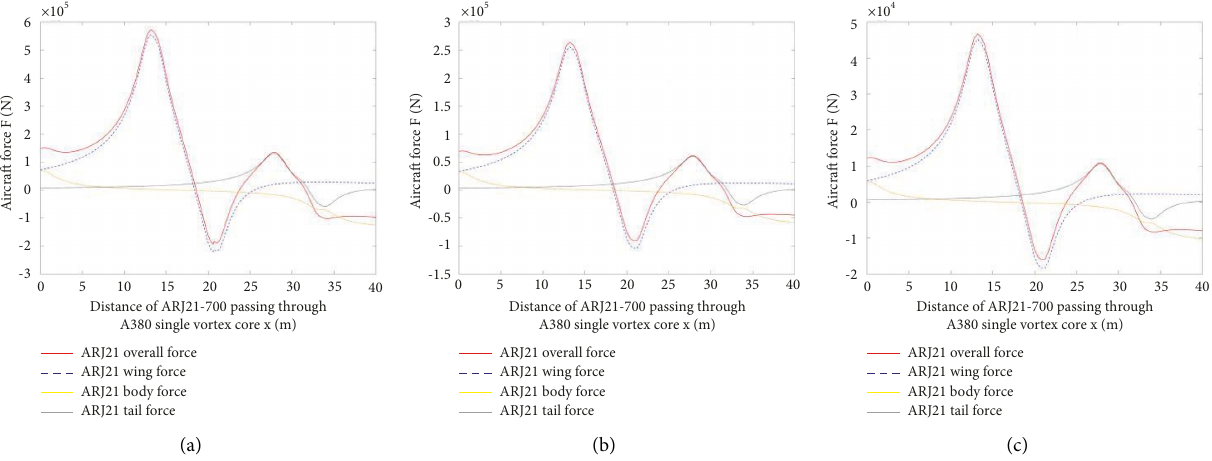
Figure 13: Stress diagram of CRJ900 across the front wake vortex. (a) Takeoff phase. (b) Level flight phase. (c) Landing